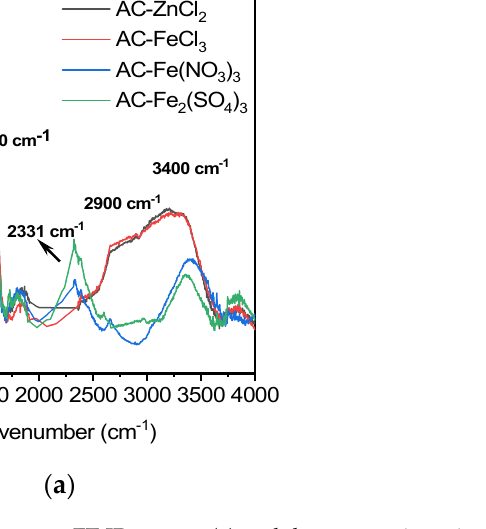
Figure 2. FT-IR spectra ( a ) and thermogravimetric analysis ( b ) of the carbon materials.